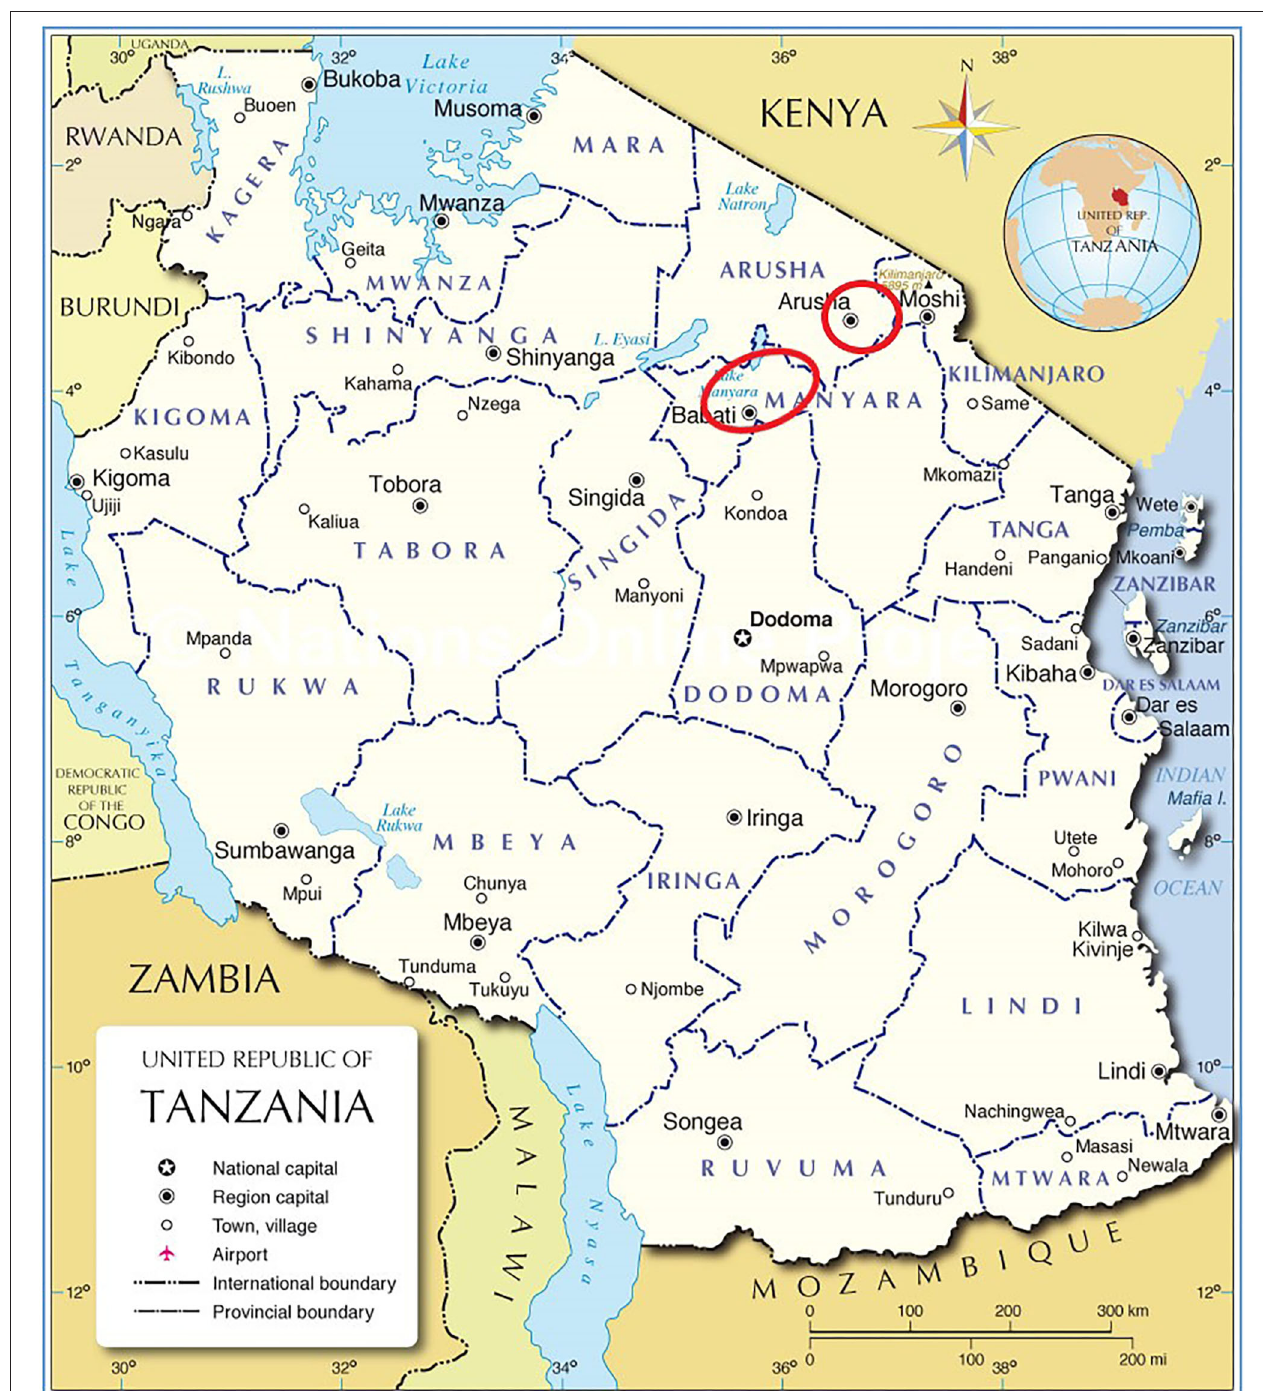
FIGURE 1 | Map of Tanzania with administrative boundaries indicating the study areas in red circles. Source: OPNO (2020).